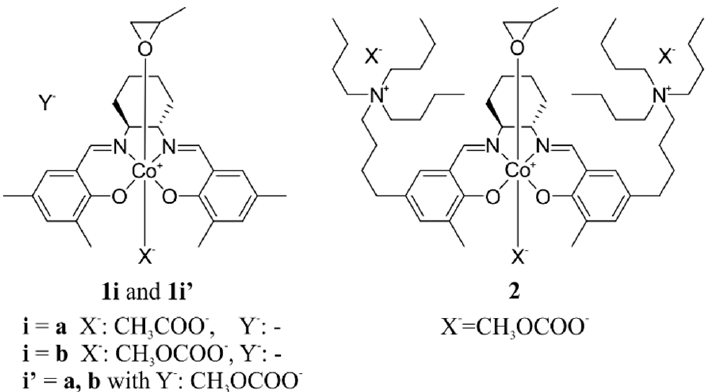
Figure 4. Schematic representation of Co(III) complexes studied in the presented work. The model systems 1 and 1 ′ differ in the presence of the methyl carbonate anion (Y − ) reacting with epoxide, which is omitted in 1a and 1b , but included in 1a’ and 1b’ ; as no additional ammonium cation was considered for 1a’ and 1b’ , such systems are thus anionic. Note that 1 and 1 ′ are simplified models of 2 .